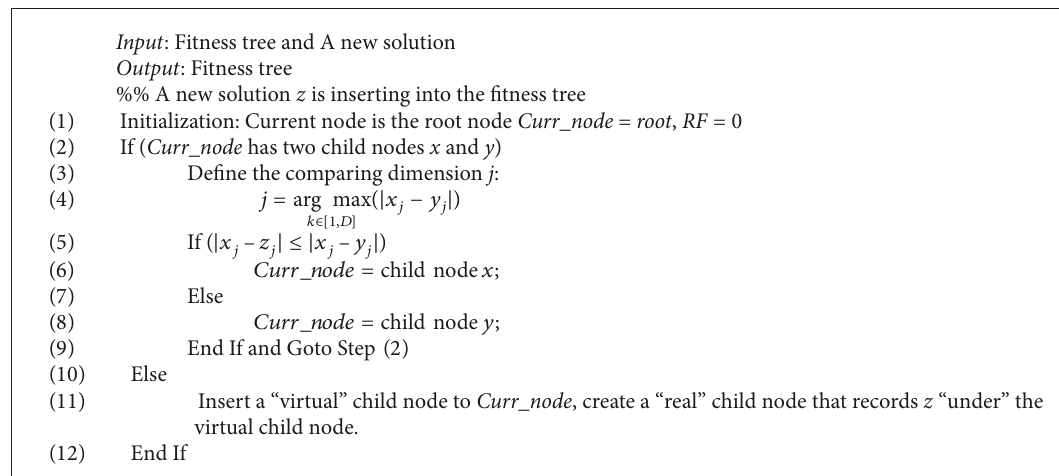
Algorithm 1: Pseudocode of fitness tree